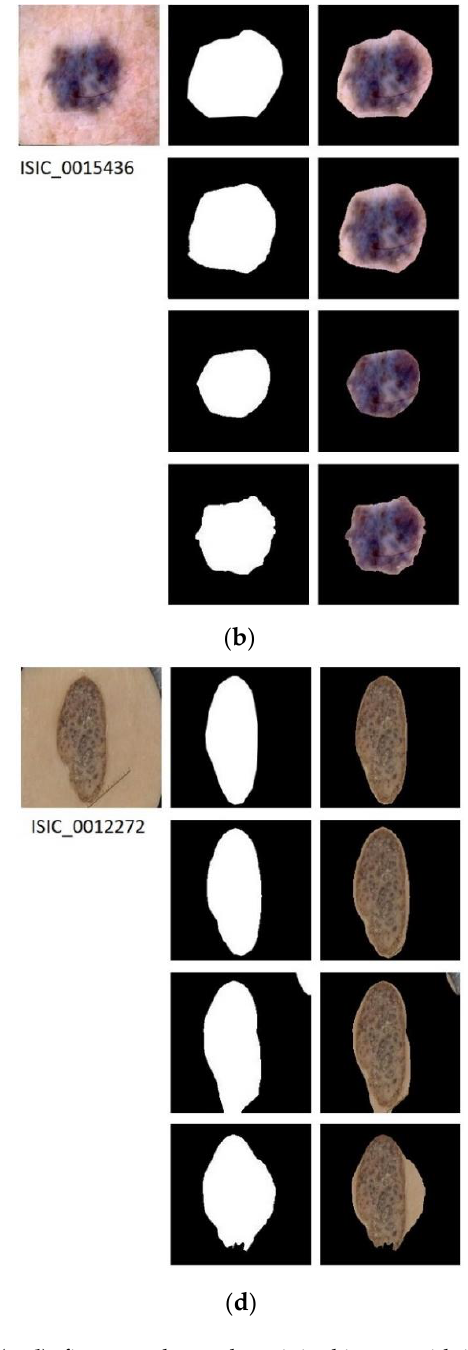
Figure 4. Segmented Images. For images ( a – d ): first row shows the original image with its ground truth mask and its corresponding segmentation result; second row shows the results of applying semantic segmentation with SegNet; third row shows the result of energy minimization algorithm via convex optimization; fourth row shows the result of segmentation based on VGG16 feature images. Table 1. Segmentation results of the tested methods over the Test set (600 images). Numbers rep- resent the average values of the different segmentation performance parameters calculated over the 600 test images.